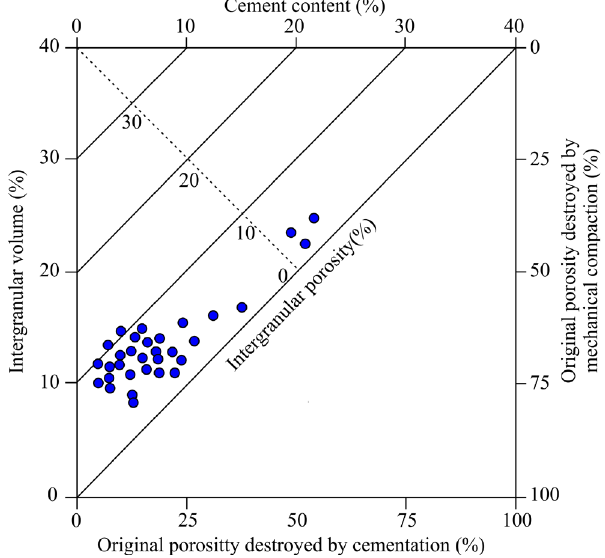
Figure 7. The relationship between the intergranular volume and the cementation volume of the J 1 a tight reservoir (modified from Longlong Liu, 2020 [43]).